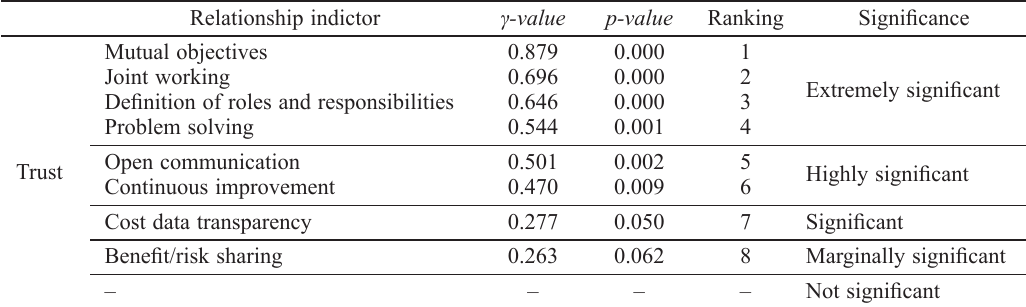
Table 1. Association between trust and key relationship